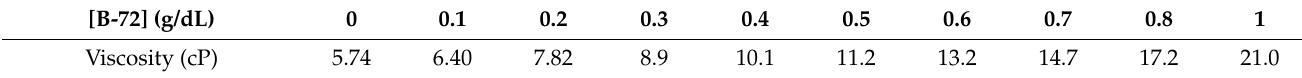
Table 3. Viscosity of B72-benzyl alcohol solutions.